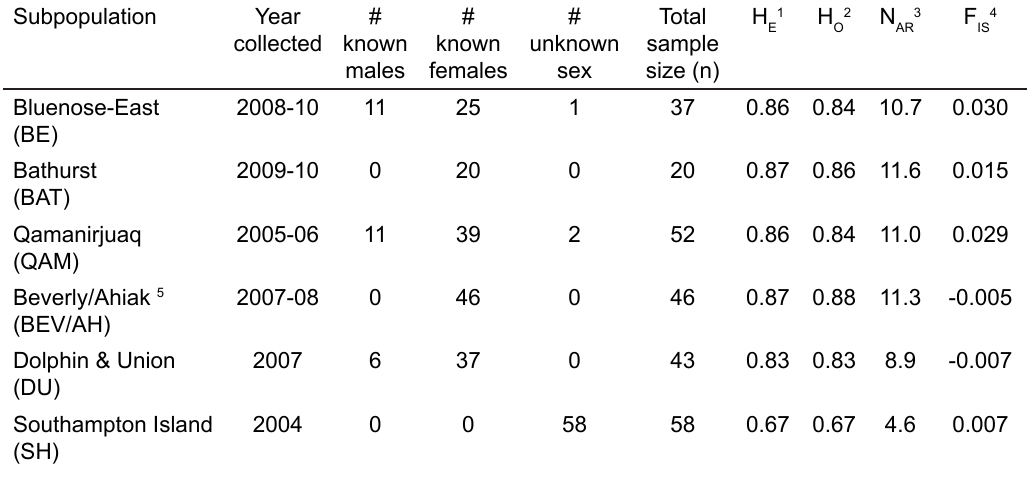
Table 1. Sample characteristics and genetic variation of Canadian migratory barren-ground caribou